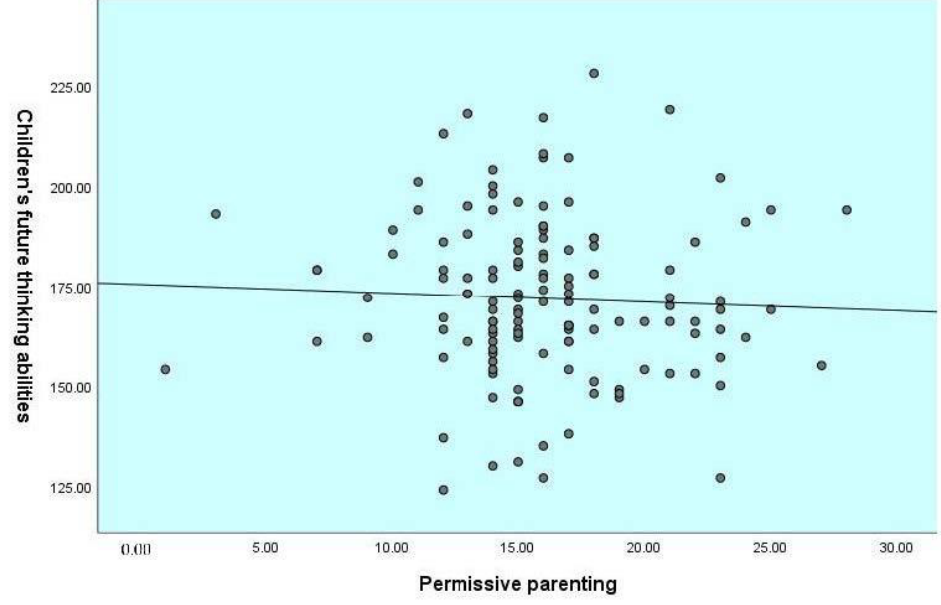
Figure 1. Correlation between permissive parenting and children’s future-oriented cognition total score.